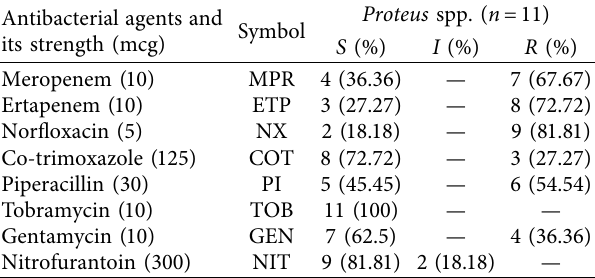
Tobramycin (10) — S , sensitivity; I , intermediate; R , resistant. Table 6: Antimicrobial susceptibility profles of Proteus spp. at the Wolaita Sodo University wastewater treatment plant. Antibacterial agents and its strength (mcg)